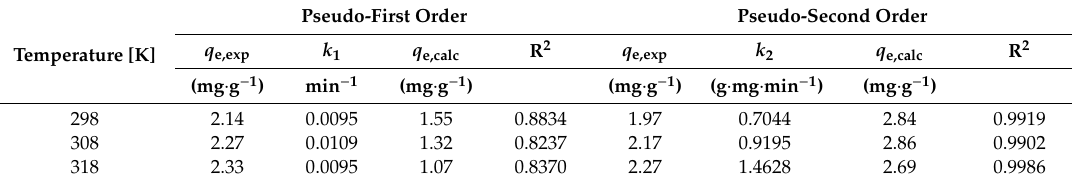
Figure 10. Plots of pseudo- first- order ( a ) and pseudo- second- order ( b ) kinetic models for the Pb 2+ adsorbtion onto magnetic nanocomposite MNPs35@SiO 2. Table 7. Kinetic parameters of Pb 2+ adsorption onto the magnetic nanocomposite.